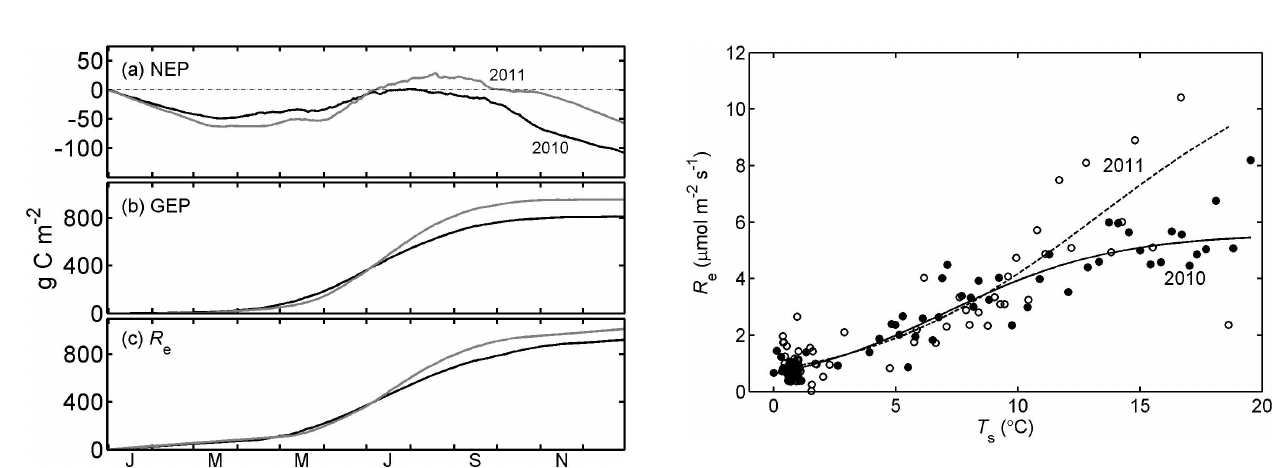
Fig. 6. Cumulative annual (a) net ecosystem production (NEP), (b) gross ecosystem photosynthesis (GEP) and (c) ecosystem respira- tion ( R e ) in 2010 and 2011.